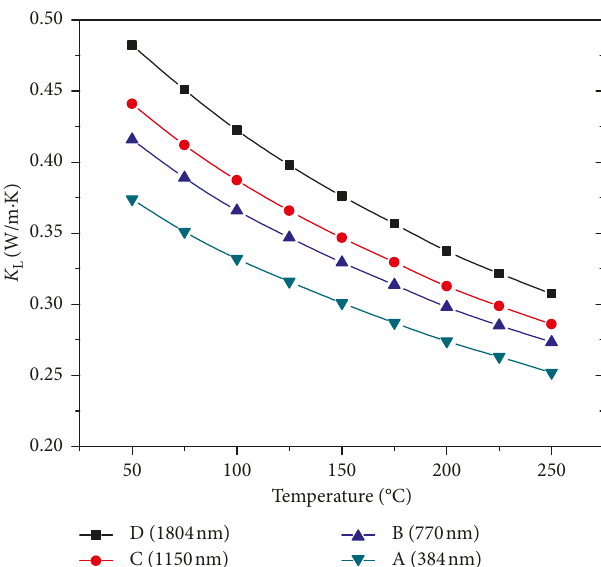
Figure 6: Theoretical calculation of lattice thermal conductivity for Sb 2 Te 3 thin films as a function of measuring